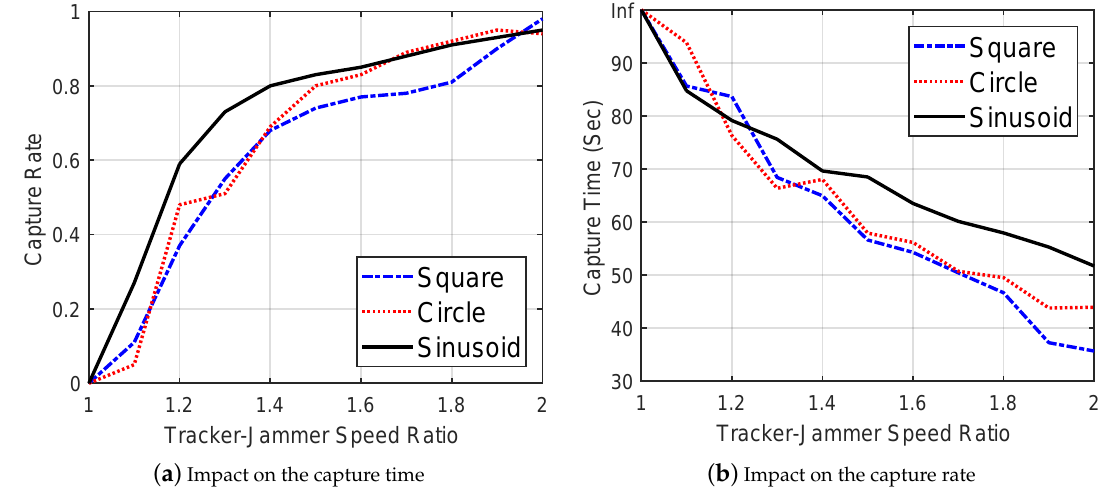
Figure 12. The impact of the tracker-jammer speed